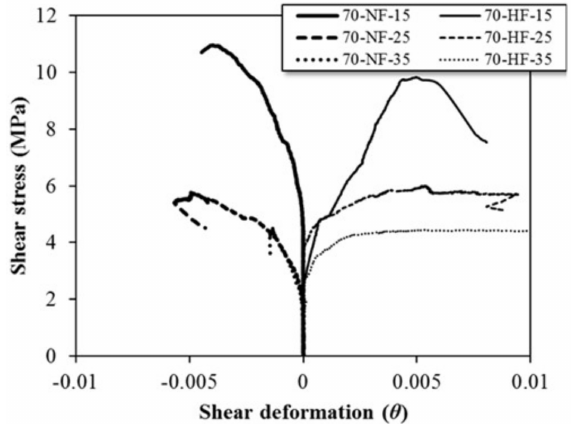
Figure 7. Effect of fiber tensile strength on shear deformation of steel fiber-reinforced concrete beam